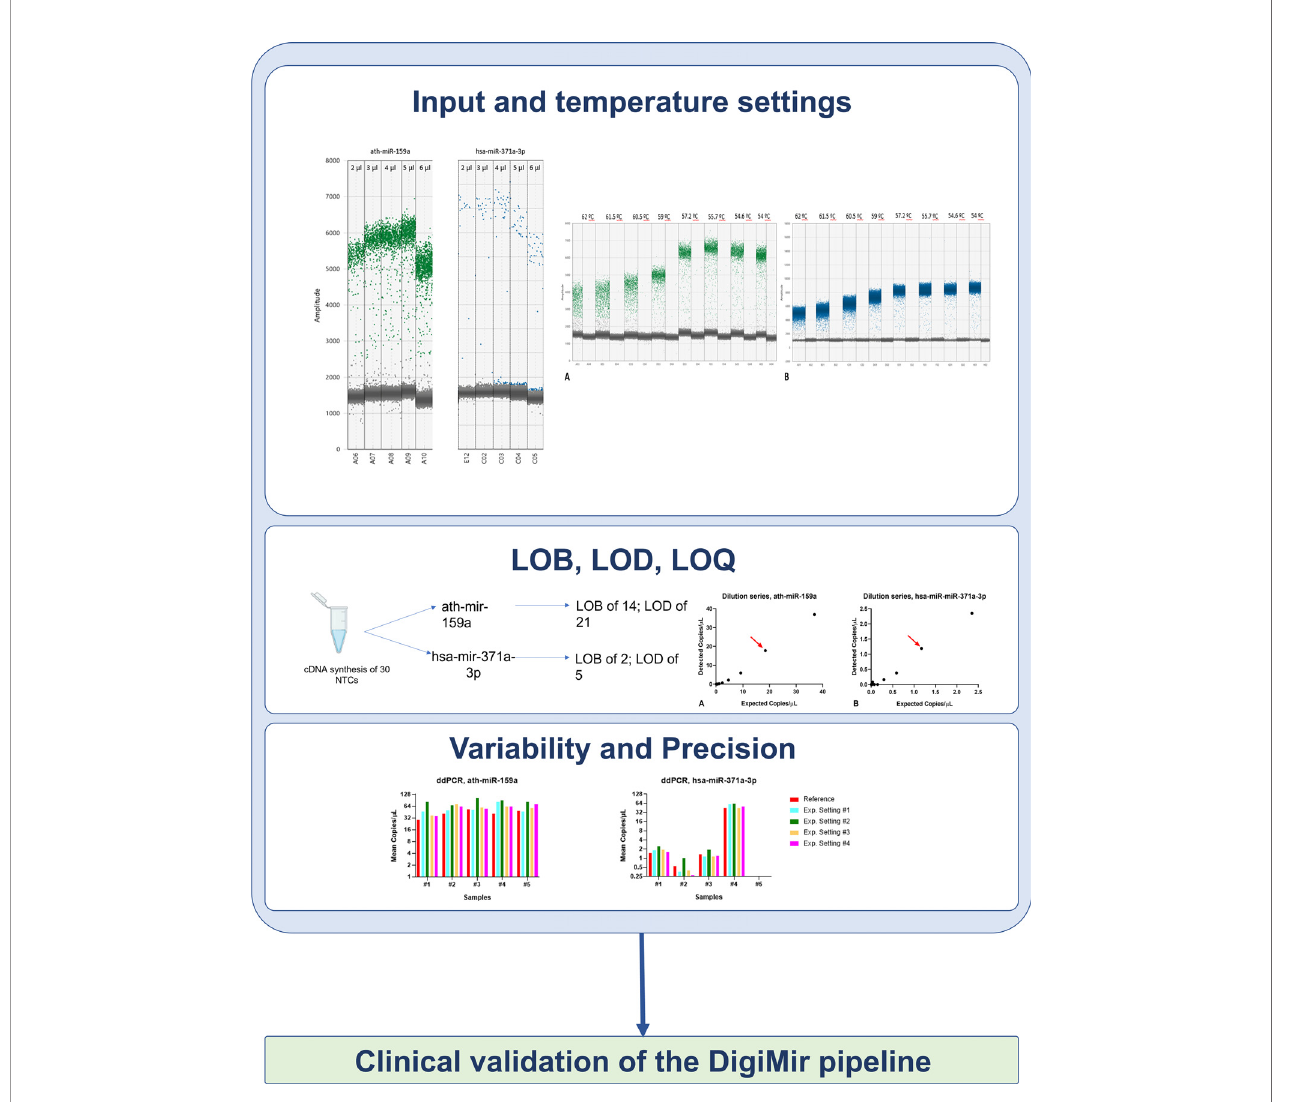
FIGURE 8 | DigiMir pipeline optimization